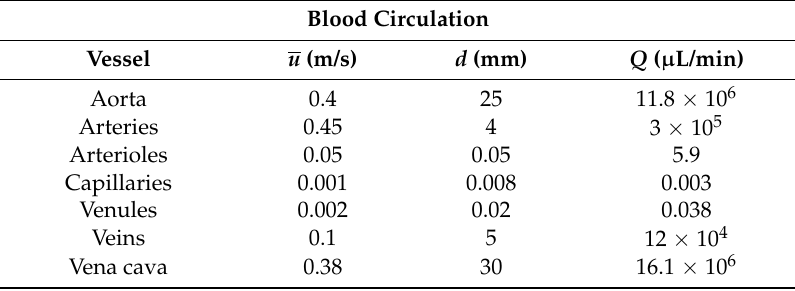
Table 1. Values for mean velocity ( u ), diameter ( d ) and flow rate ( Q = ( u π d 2 )/4) of the vessels in the blood circulation [22,23].